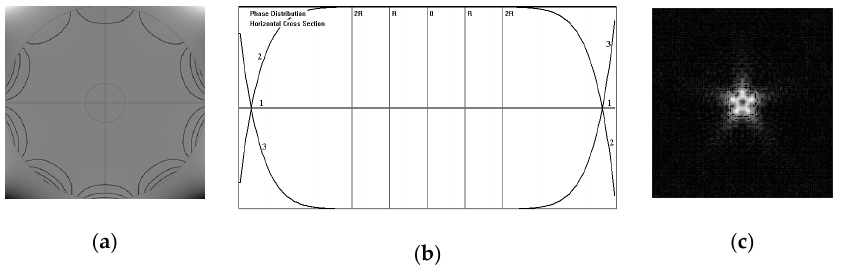
Figure 5. The same as in Figure 2, the phase was specified by polynomial No. 20. Phase surface ( a ), cross-sections of phase surface ( b ) and corresponding amplitude distribution ( c ) are shown.